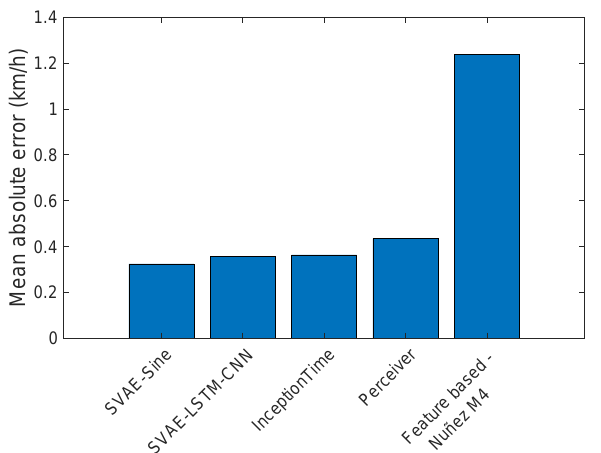
Figure 4. Mean absolute error of speed prediction obtained by the four tested deep methods and the best feature-based method [24] (M4 from Table 5). Results are averaged over 8 subjects of the leave-one-out cross-validation. All methods were optimized for best performance.